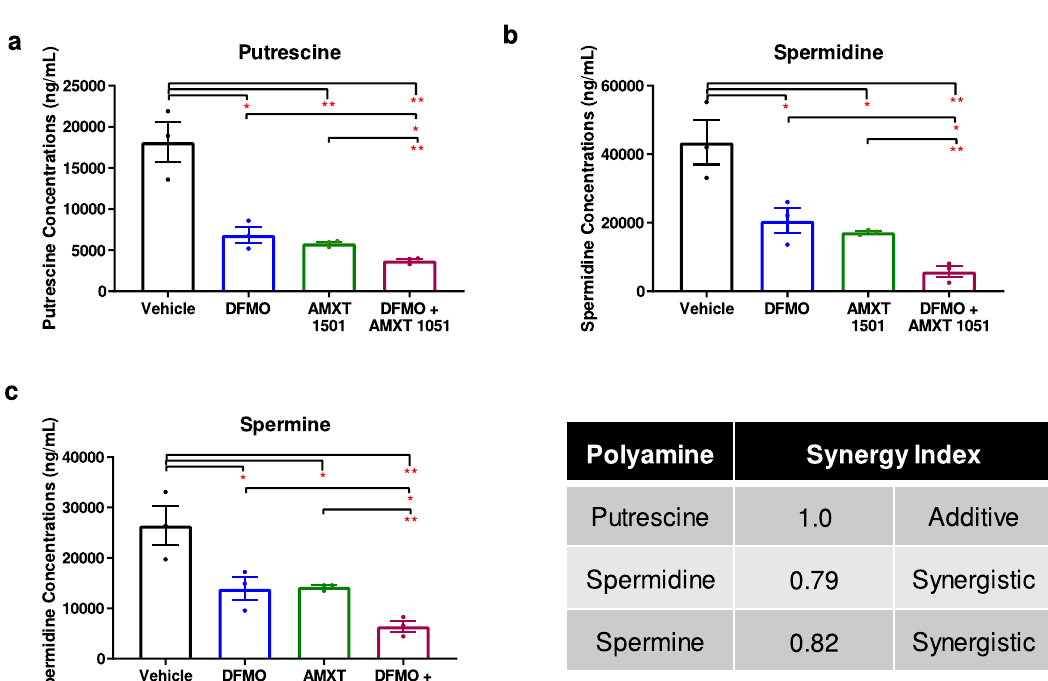
Fig. 3 Inhibition of synthesis and transport depletes intracellular polyamines. ( a ) Putrescine, ( b ) Spermidine, and ( c ) Spermine levels in SU-DIPGVI cells treated with DFMO and AMXT 1501 alone and in combination. Data are presented as means ± SEM of three independent experiments. * p < 0.05, ** p < 0.01. p-values were calculated using one-way ANOVA for untreated and treated samples. Synergy calculated using the Chou – Talalay method. a Vehicle vs DFMO: p = 0.0125, Vehicle vs AMXT 1501: p = 0.0072, Vehicle vs DFMO + AMXT 1501: p = 0.0041, DFMO vs DFMO + AMXT 1501: p = 0.0378,